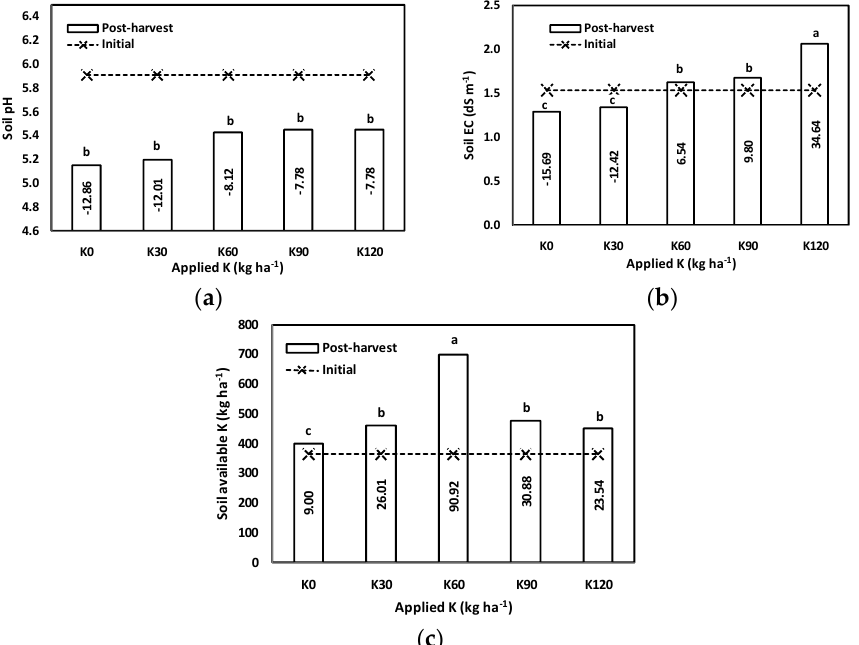
Figure 3. Soil pH ( a ), EC (dS m − 1 ) ( b ), and available K (kg ha − 1 ) ( c ) at different levels of K (kg ha − 1 ) (means followed by same letter are statistically at par, otherwise significantly different at p ≤ 0.05 by Tukey’s HSD (honest significant difference) test; data within bars are percent increase or decrease ( − ) in any parameter from its initial value). Table 6. Potassium balance in soil after harvesting of hybrid rice (var. Arize 6444) as influenced by